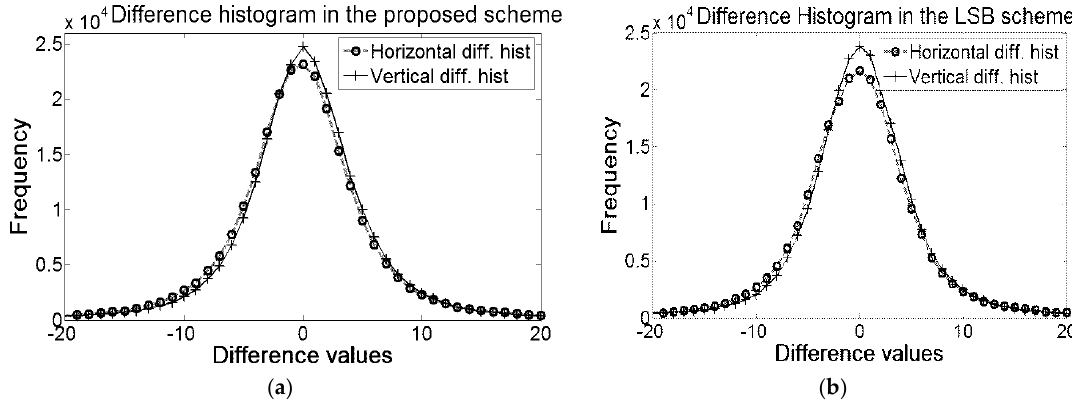
Figure 11. Vertical and horizontal difference histograms which are computed in the ( a ) proposed scheme and ( b ) LSB replacement scheme.